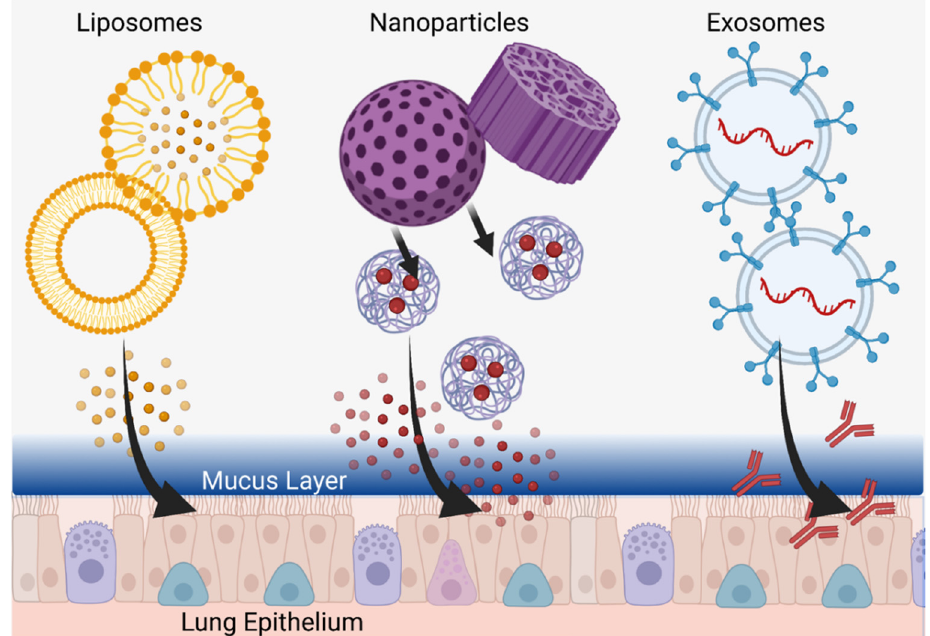
Figure 4. Customized Delivery Systems. Liposomes (left), nanoparticles (center), and exosomes (right) can be tailored to penetrate into the deepest parts of the lung and deliver therapeutics directly to epithelial cells through the mucus layer. Created in BioRender.com.